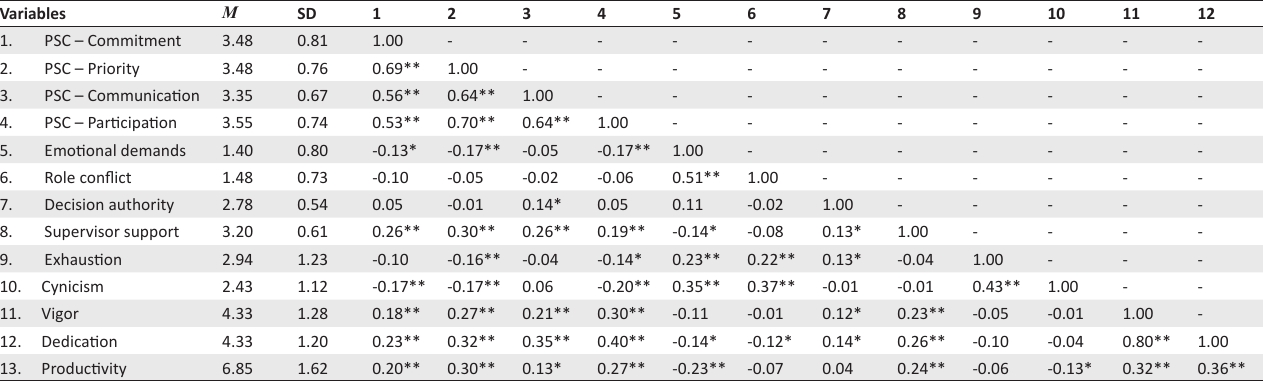
TABLE 1: Means ( M ), standard deviations (SD) and correlation between the study variables. Variables M SD